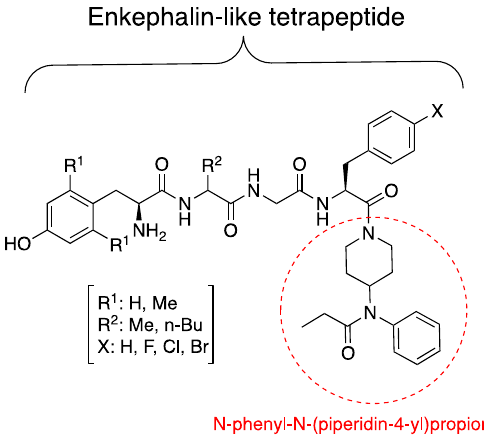
Figure 1. Structures of enkephalin-like tetrapeptide analogs.